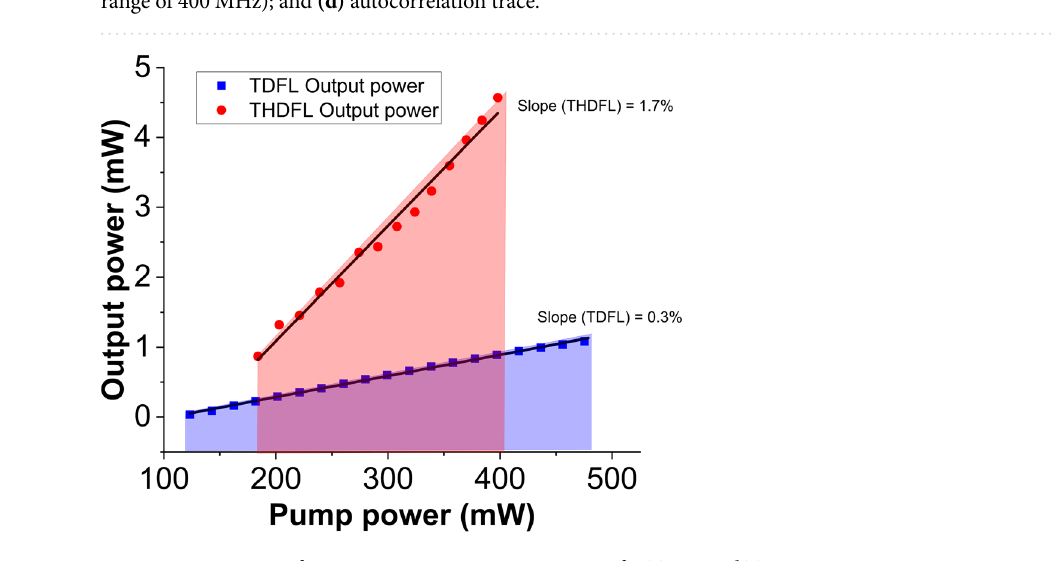
Figure 8. Variation of output power against pump power for TDFL and